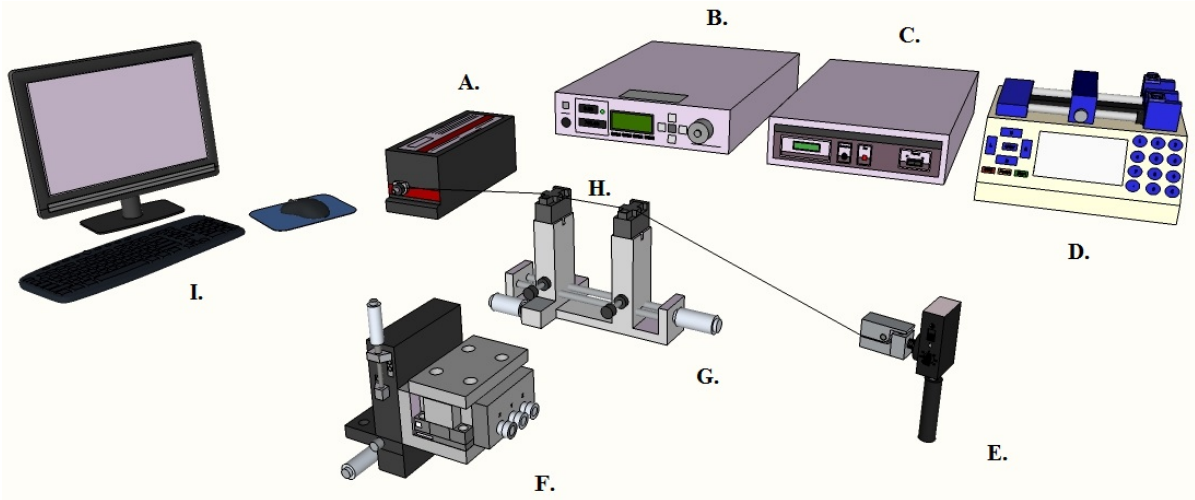
Figure 6. The experimental setup of device characterization. A —Laser B —Laser Controller C —Stage Controller D —Syringe Pump E —Photo Detector F —Nano-Positioning